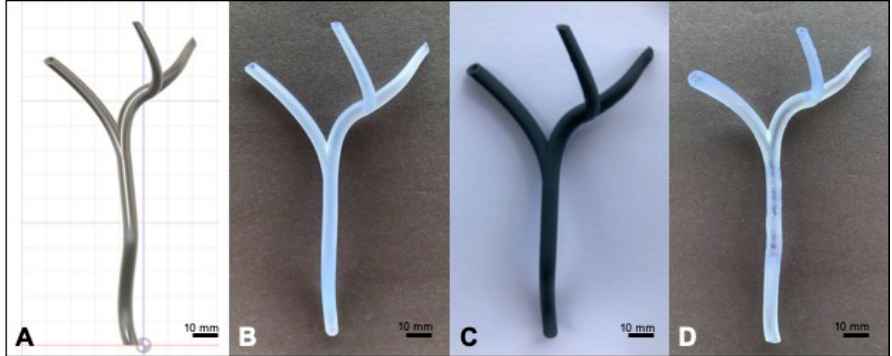
Figure 3. CAD extrahepatic bile ducts (EHBD) model and 3D printed EHBDs . ( A ) EHBD model in Fusion360; ( B ) EHBD model printed in Formlabs Durable resin with 0.5 mm duct walls; ( C ) EHBD model printed in Formlabs Flexible resin with 1 mm duct walls; ( D ) EHBD model printed in Formlabs Elastic resin with 0.75 mm duct walls.